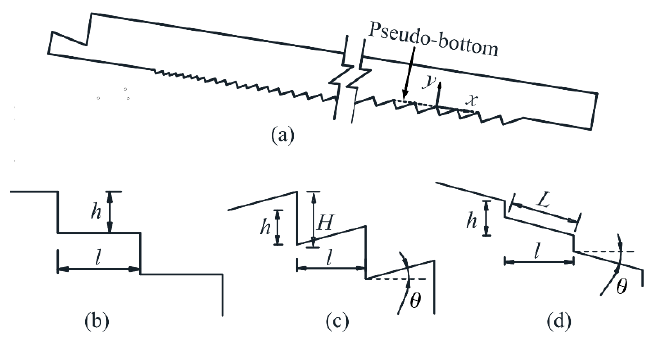
Figure 1. Sketch of the spillway ( a ) stepped spillway, ( b ) conventional layout θ = 0, ( c ) upward step θ > 0, and ( d ) downward step θ < 0.